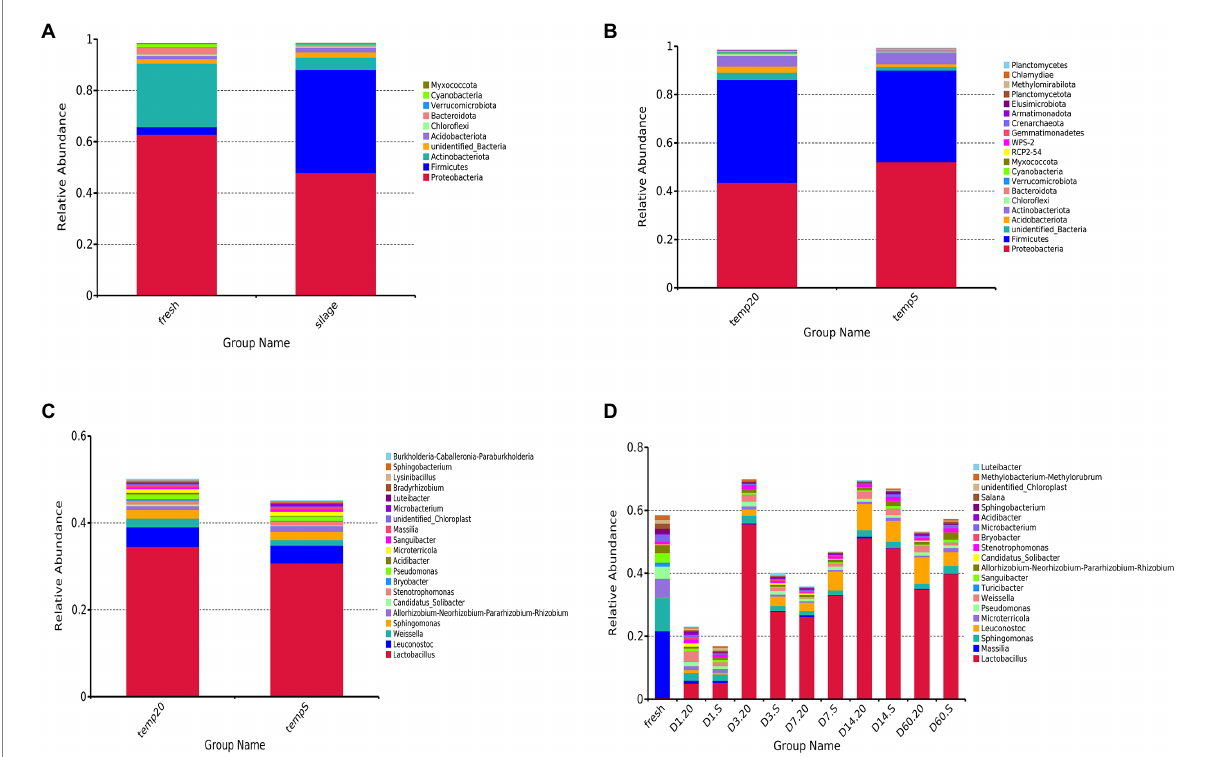
FIGURE 3 Relative abundances of bacterial community: (A) comparison of fresh oat with oat silage at the phylum level (samples were from day 1 to day 60, and were considered as a whole); (B) comparison of the 20 group with the S group at the phylum level (all samples were from day 1 to day 60 and were considered as a whole); (C) comparison of the 20 group with the S group at genus level (all samples were from day 1 to day 60 and were considered as a whole); (D) comparison of each period (fresh, 1, 3, 7, 14, and 60 days) in both treatments at the genus level. 20, constant temperature of 20 ° C; and S, freeze–thaw condition, alternating 20 ° C, and − 5 ° C every 12